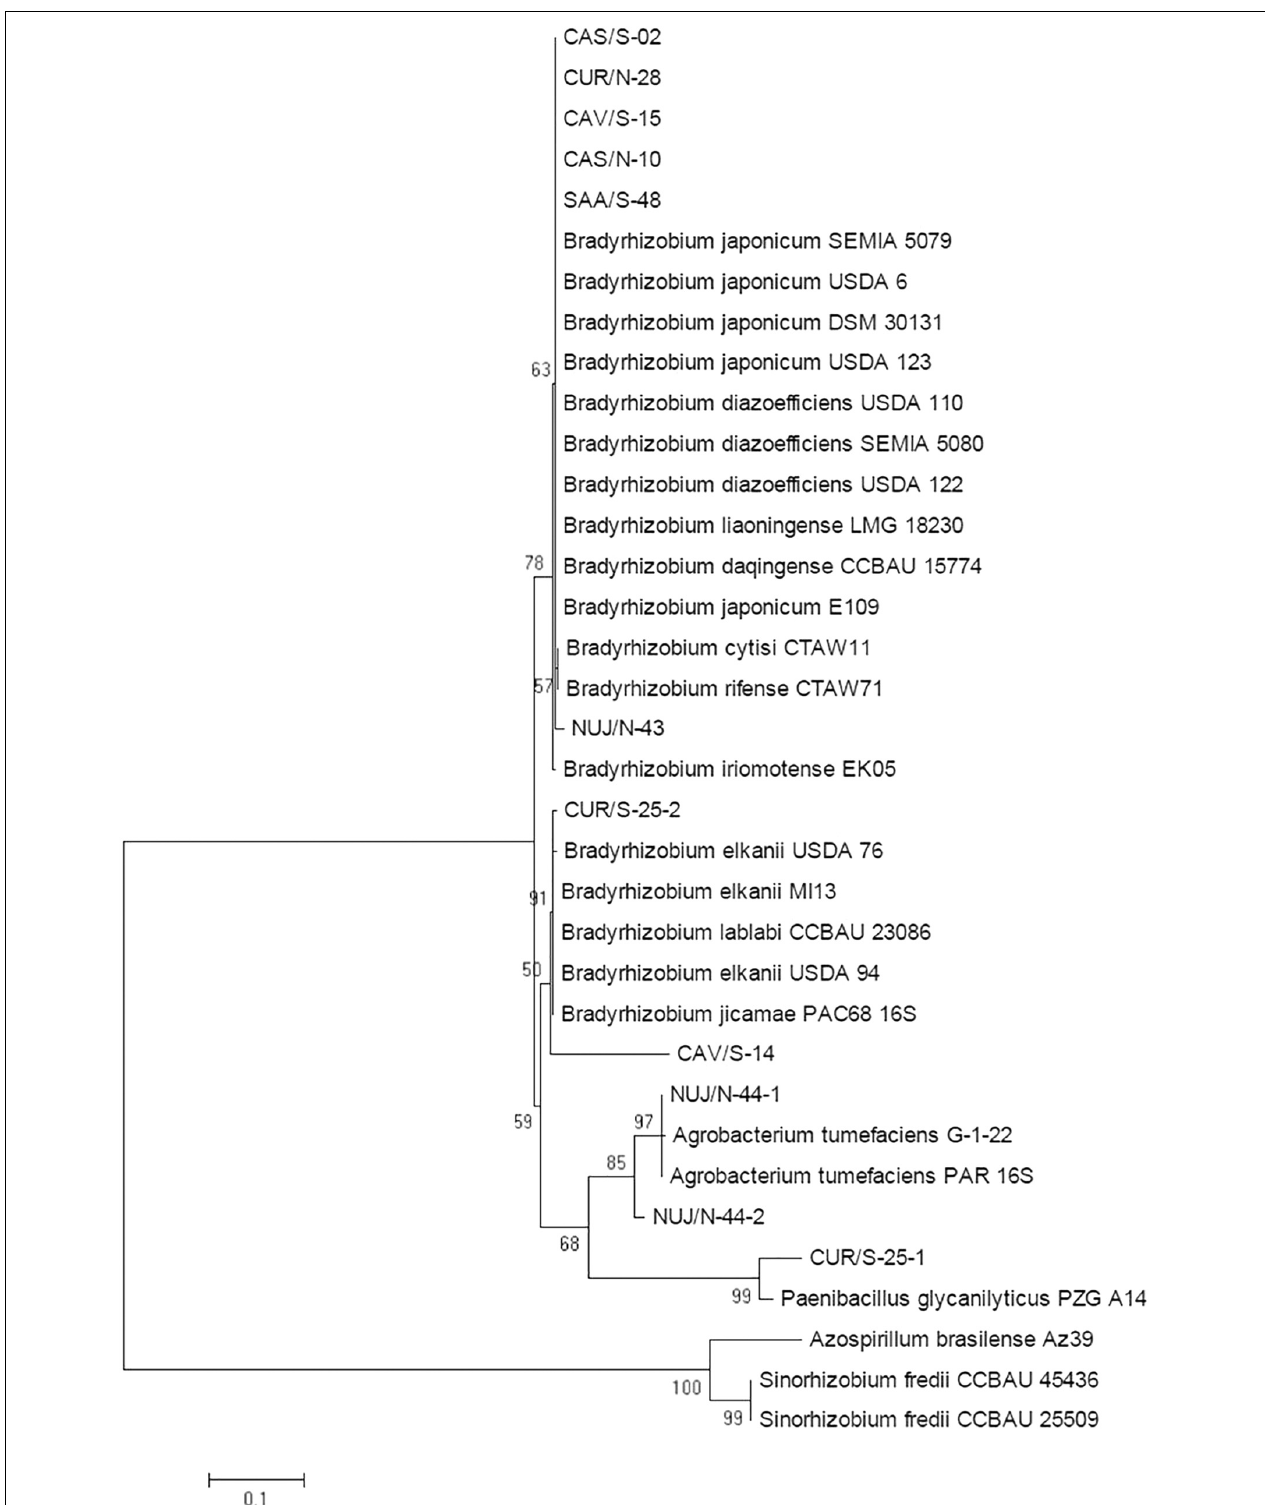
FIGURE 2 | Maximum likelihood cladogram for the 16S rRNA sequences of picked SNAP-isolates and reference strains. Next to the nodes the percentage of replicate trees in which the associated taxa clustered together in the bootstrap test with 1,000 replicates are shown. Branch lengths in the tree are scaled in the same units as those of the evolutionary distances (scale bar) used to infer the phylogenetic